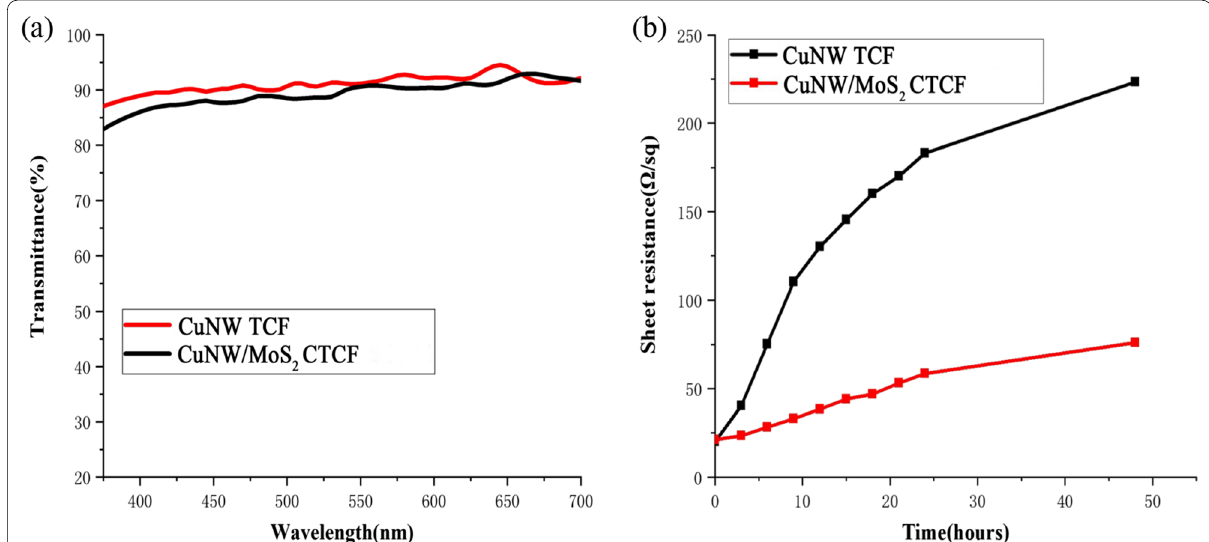
Fig. 7 Optoelectronic properties comparison of a CuNW TCF and a CuNW/MoS 2 CTCF. a CuNW TCF and CuNW/MoS 2 CTCF possess similar transmittance spectra. b CuNW TCF and CuNW/MoS 2 CTCF square resistance curve with